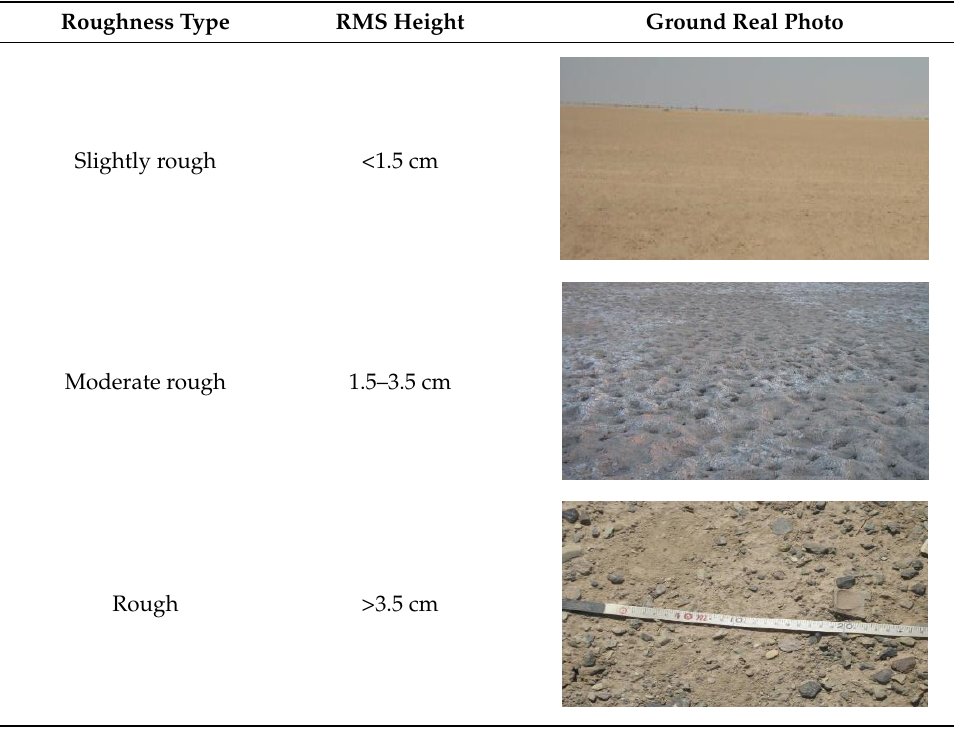
Figure 2. Profile line (2.5 m) of surface roughness modeling with photogrammetry technique in GIS.